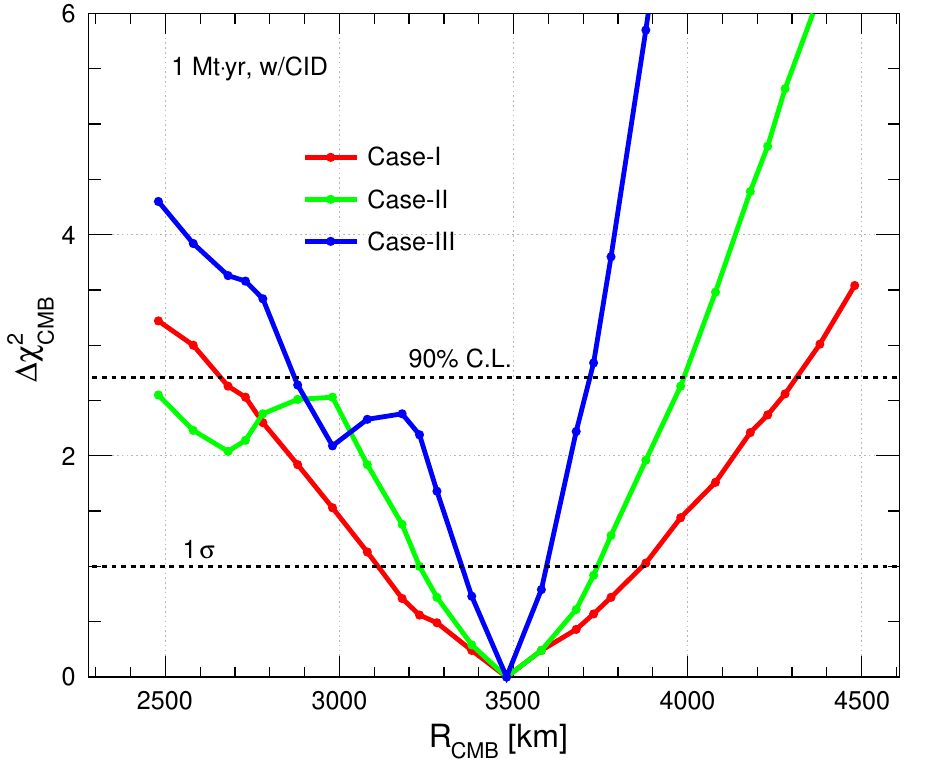
sensitivities as functions of the location of CMB. The red, green, Figure 8 . The median ∆ χ 2 CMB and blue curves represent Case-I, Case-II, and Case-III, respectively. The ∆ χ 2 minimization has CMB been performed by varying test values of sin 2 θ and ∆ m 2 over their current uncertainties, and 23 eff taking both mass orderings NO and IO. The results correspond to 1 Mt · yr exposure with charge identification capability of ICAL. For simulating MC data, we use three-flavor neutrino oscillation parameters given in table 2, where we assume NO and sin 2 θ = 23